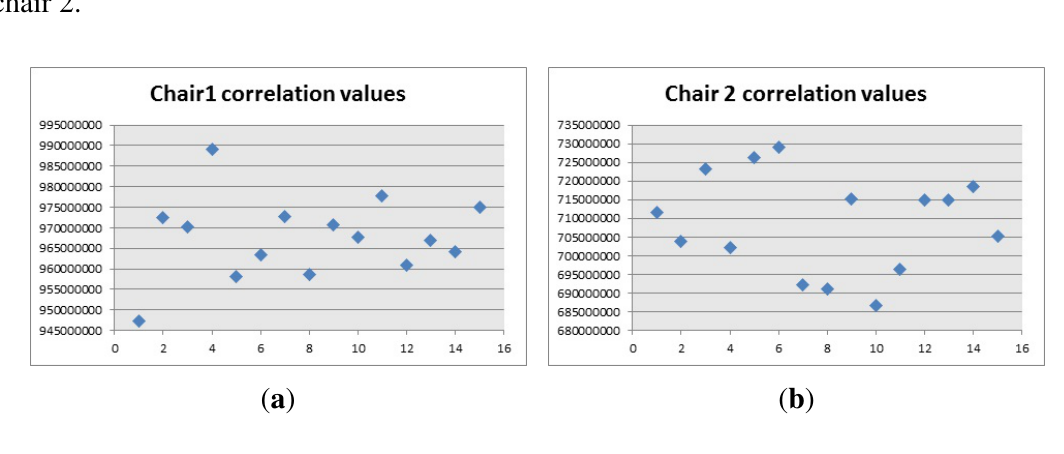
Figure 19. Correlation values. ( a ) Correlation values, chair 1; and ( b ) Correlation values, chair 2.